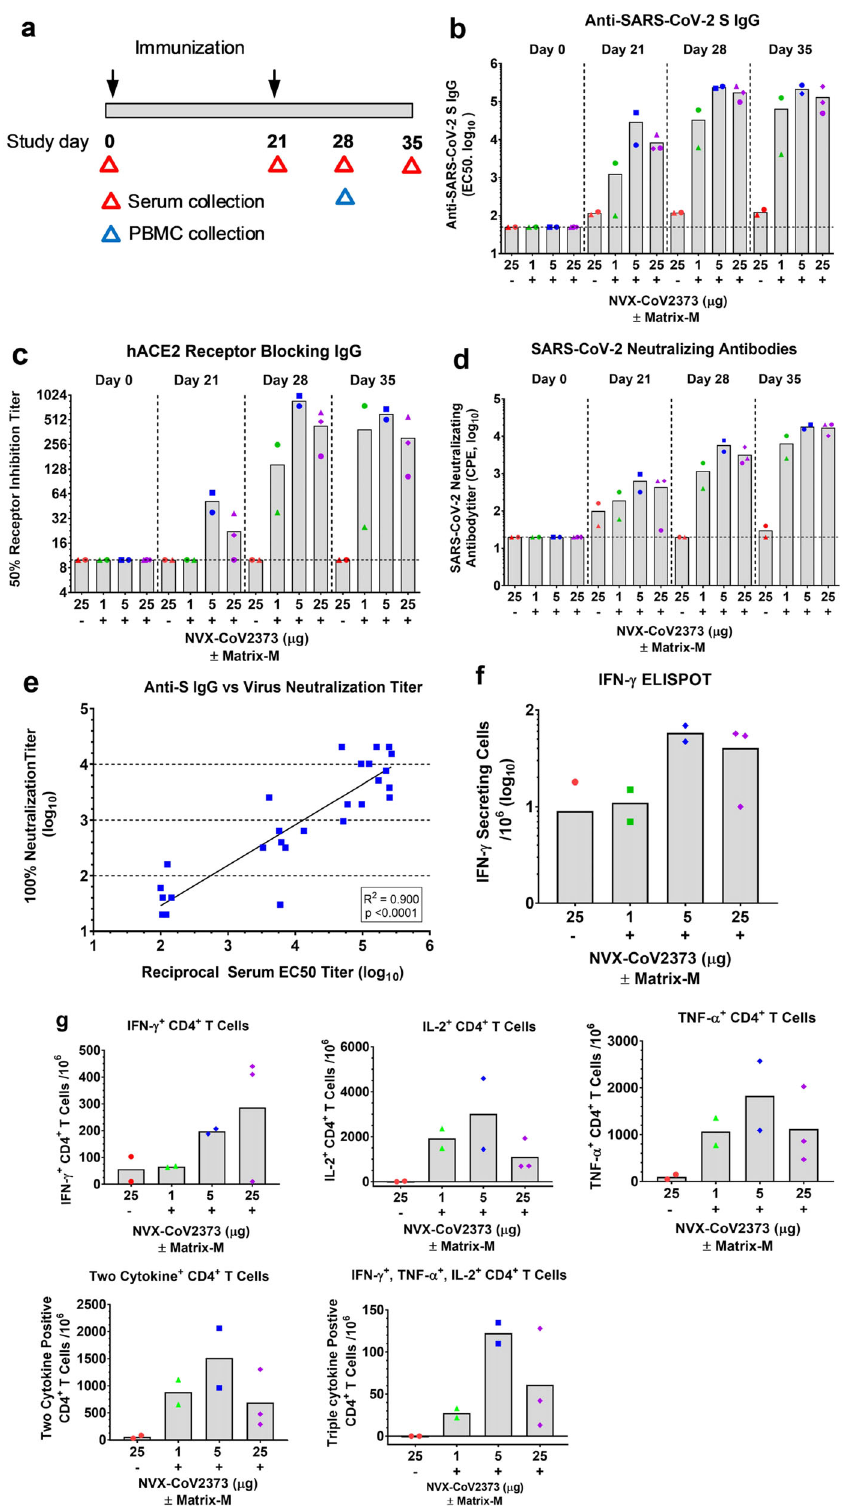
the pathology or clinical symptoms of human infection. A